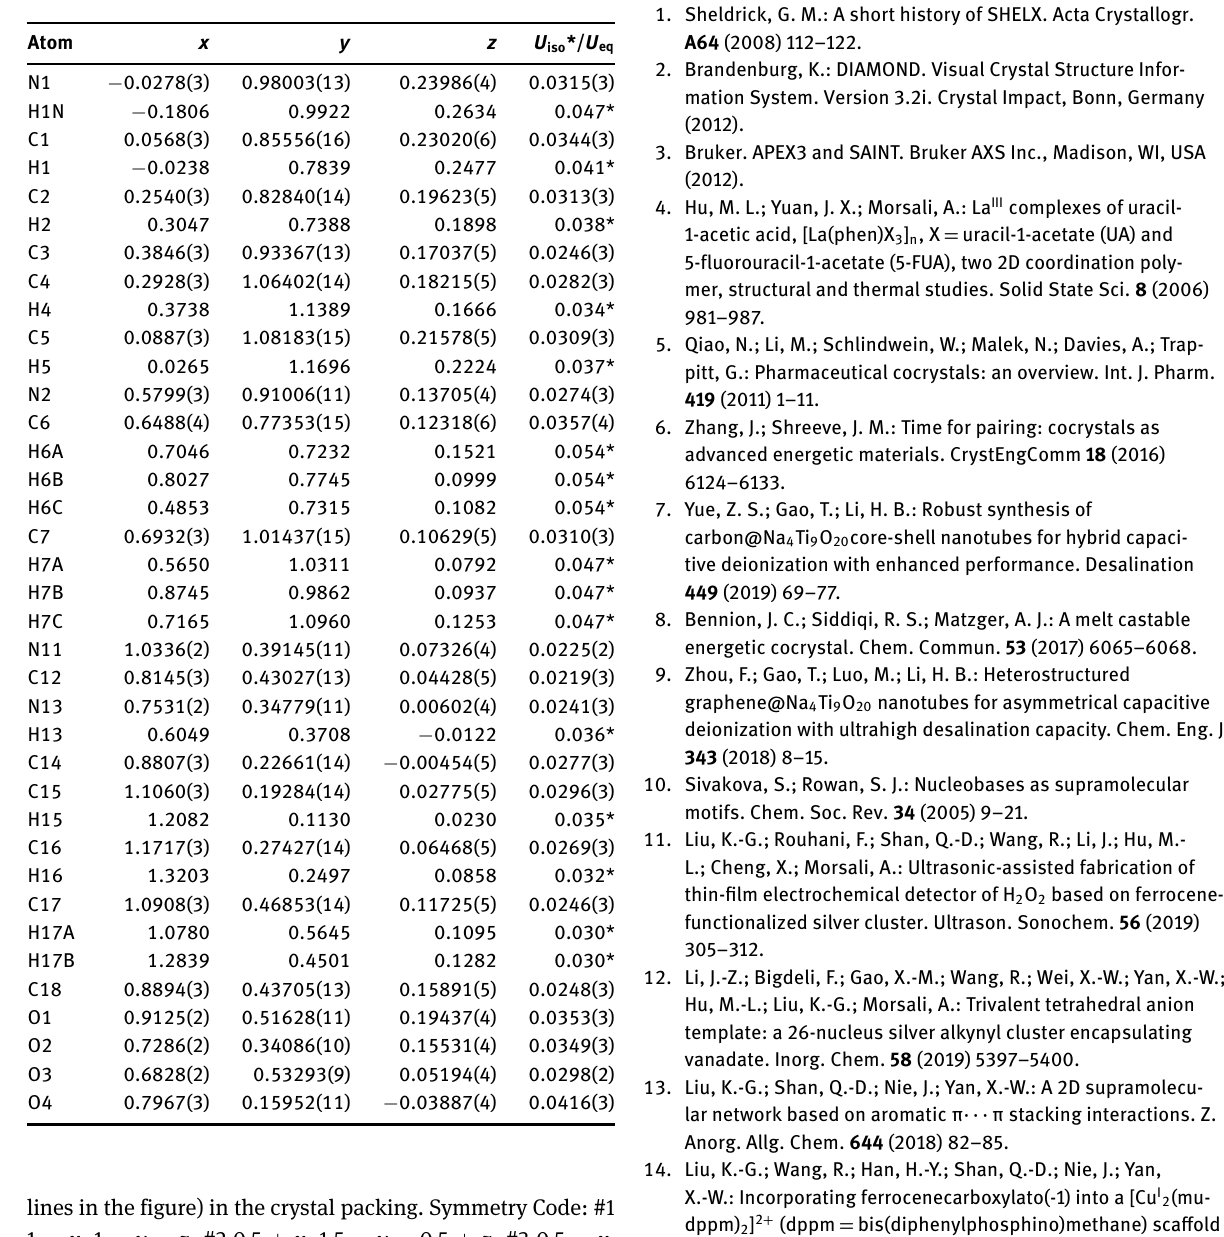
Table 2: Fractional atomic coordinates and isotropic or equivalent isotropic displacement parameters (Å 2